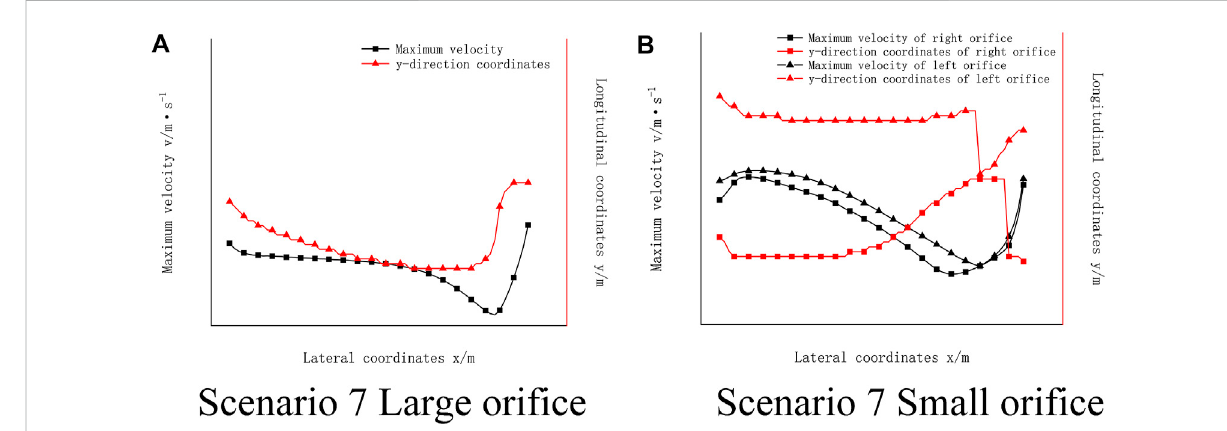
FIGURE 13 Maximum velocity and position along the way.